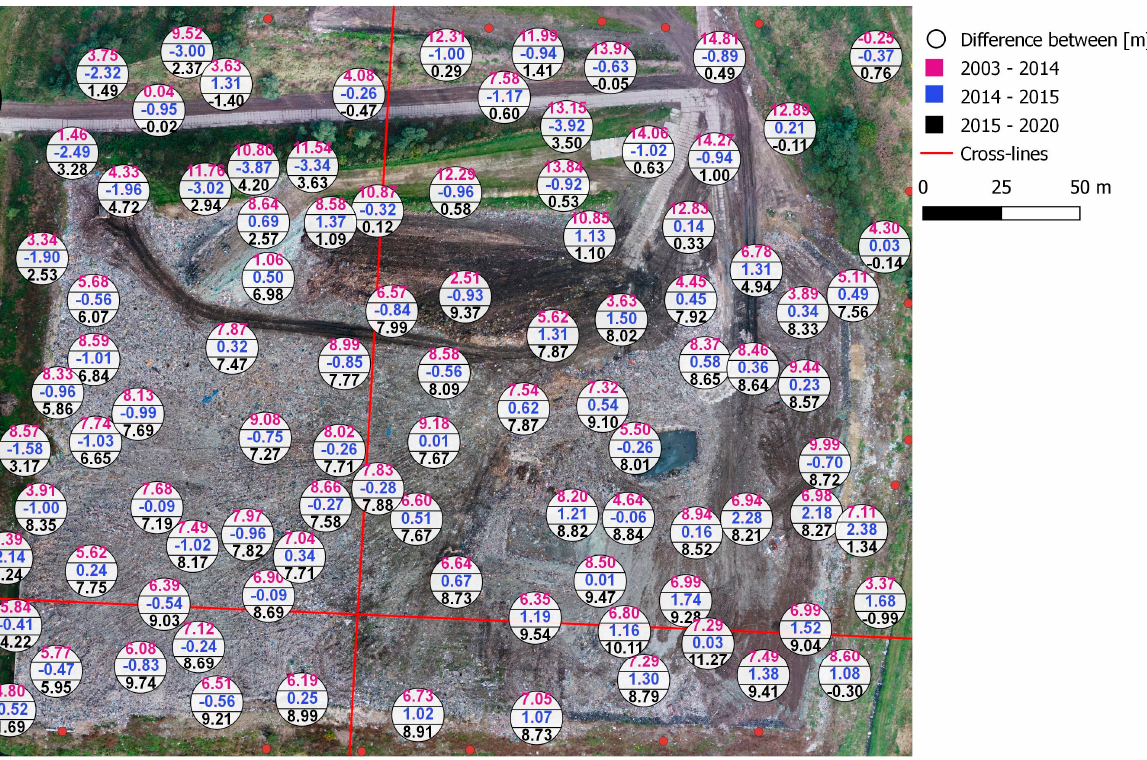
Figure 4. Cross ‐ section W–E with the profiles of dump canopy in the period 2003–2020.